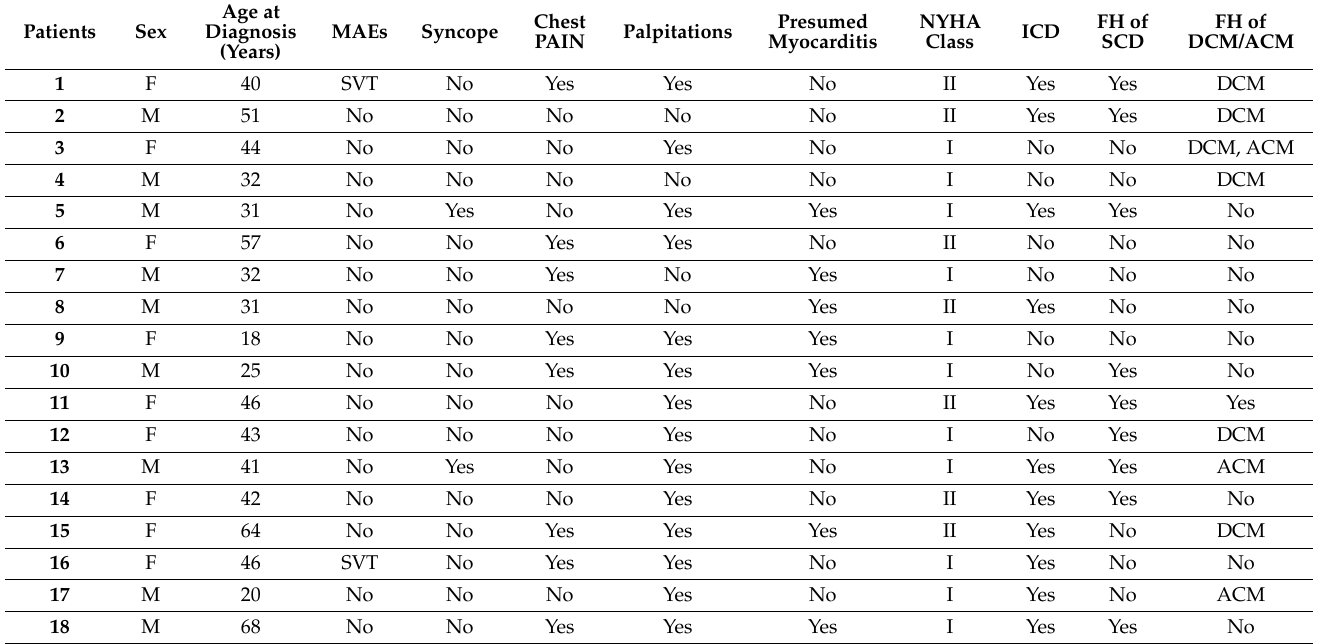
Table 2. Clinical characteristics of probands carrying likely pathogenic or pathogenic variants in desmoplakin (DSP)